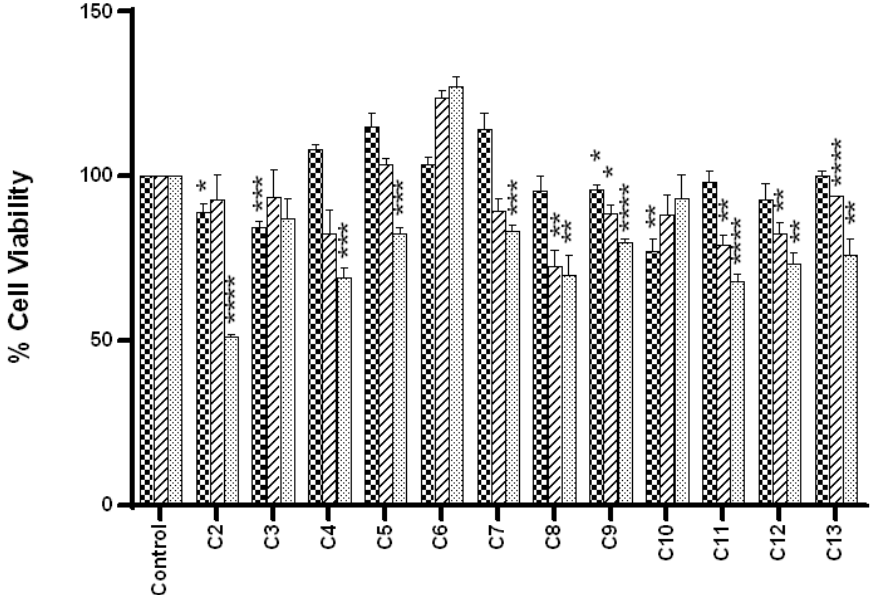
Figure 4. Cytotoxic effect of test compounds ( 2-13 ) on human neuroblastoma SH-SY5Y cells at concentrations of 10 µM, 50 µM and 100 µM, after 24 h of exposure. Data are presented as mean ± SEM (n = 9). The level of significance is expressed as: * p < 0.05, ** p < 0.01, *** p < 0.001, **** p < 0.0001.